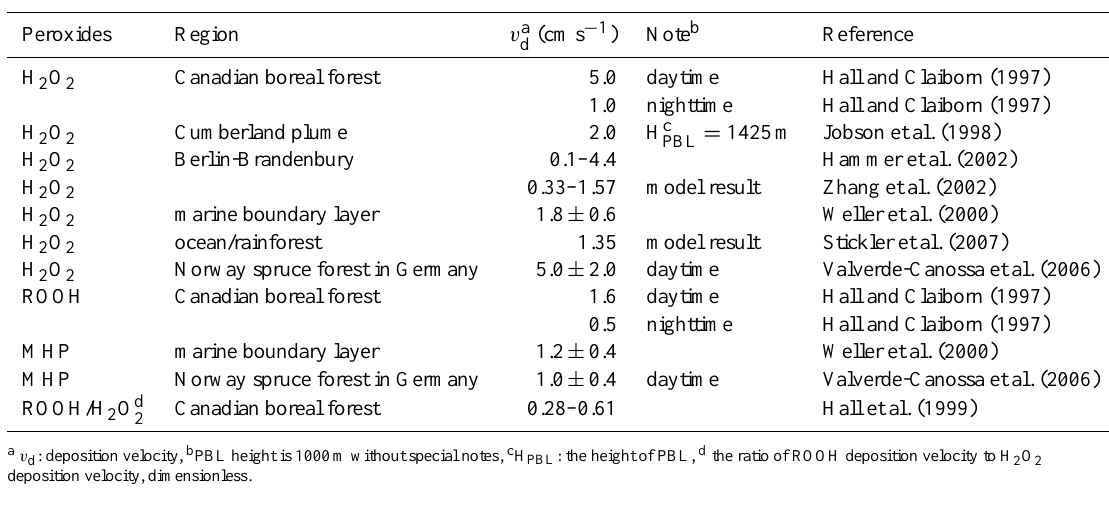
Table 2. Dry deposition velocities for peroxides reported in the literature.